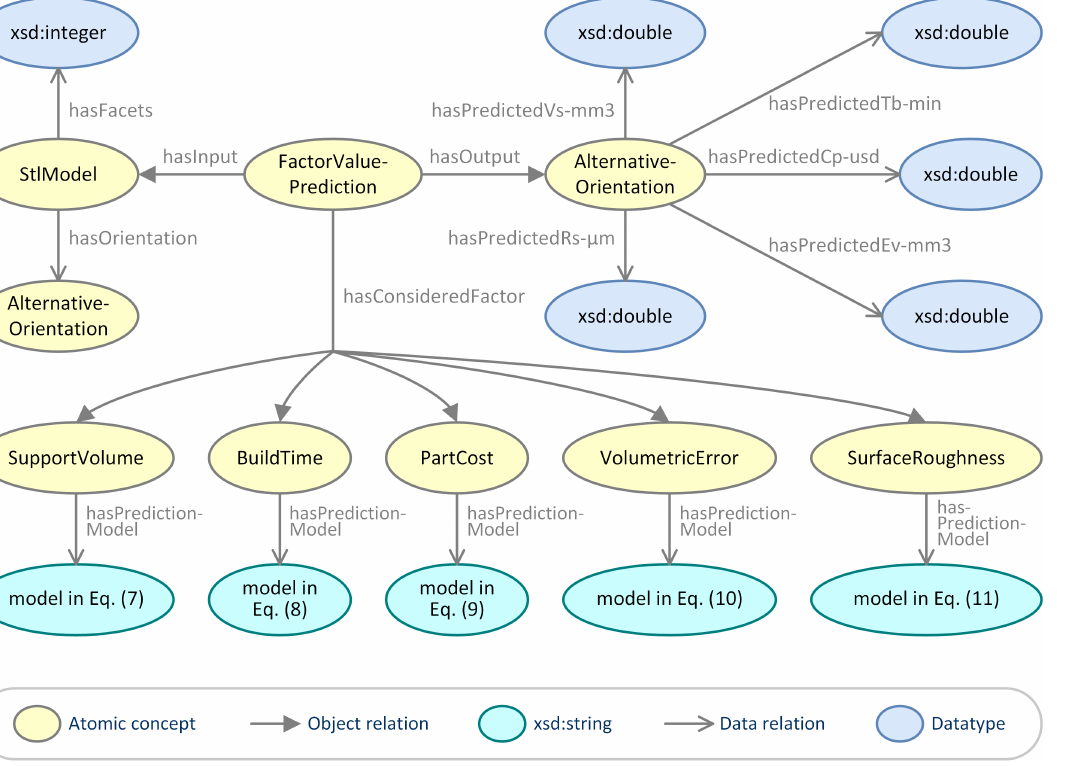
Figure 5. Ontological view of factor value